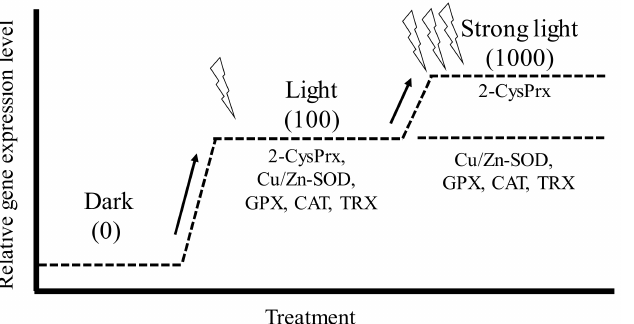
Figure 4. Conceptual diagram of gene expression pattern of six antioxidant enzymes (2-CysPRX, Cu Zn superoxide dismutase (Cu/Zn-SOD), glutathione peroxidase (GPX), catalase (CAT), and thioredoxin (TRX)) in Chattonella marina under conditions of elevated irradiance. The numbers in parentheses are light intensities ( µ mol photons m − 2 s − 1 ) [57].